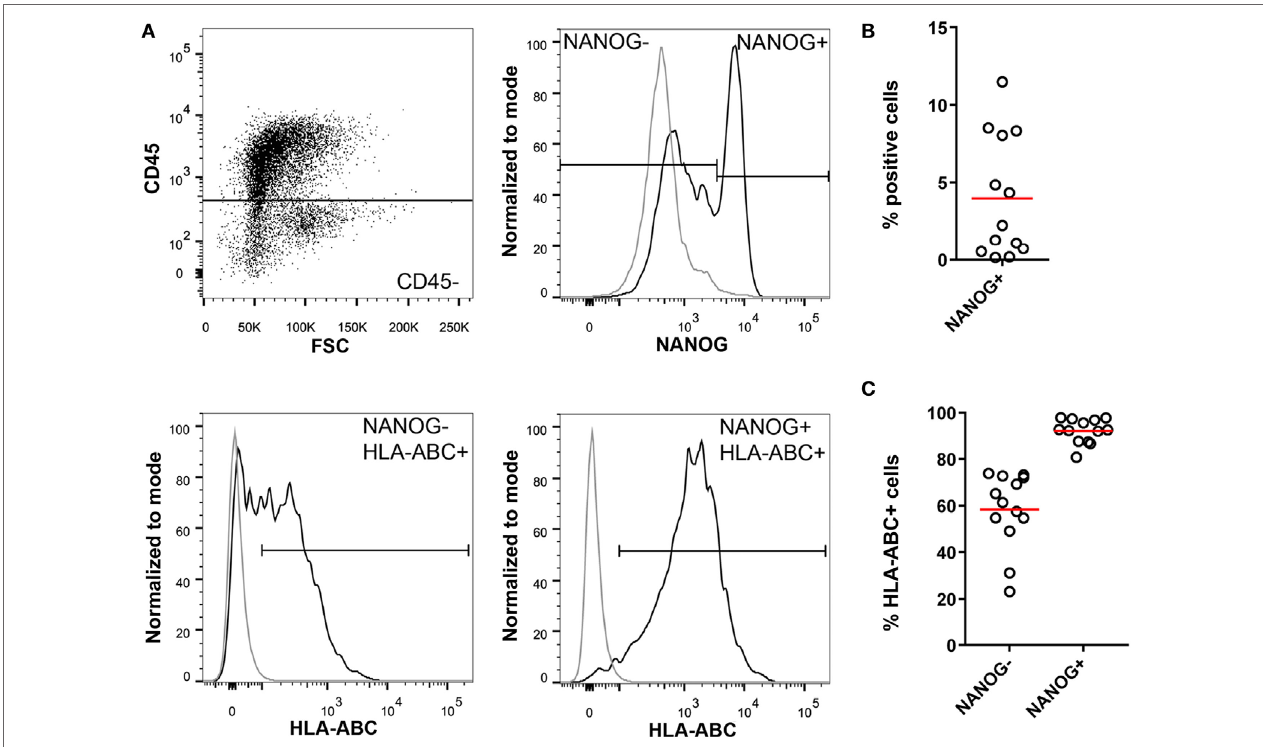
FiGUre 4 | Cancer stem cells in high-grade serous ovarian cancer ascites. (a) Isolated mononuclear cells from ascites of ovarian cancer patients ( n = 13) were stained for CD45, NANOG, and HLA-ABC. NANOG positivity was assessed in the CD45 − population to exclude immune cells. NANOG − and NANOG + cells were gated and HLA-ABC expression was analyzed in both populations. Gray line = isotype control; black line = sample. (B) Percentage of NANOG + cells in ascites. (C) Percentage of HLA-ABC positive cells in the NANOG − and NANOG + population. Red line indicates